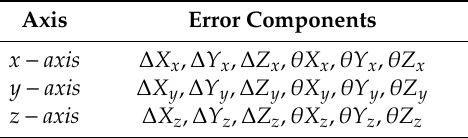
Table 3. Components of geometric